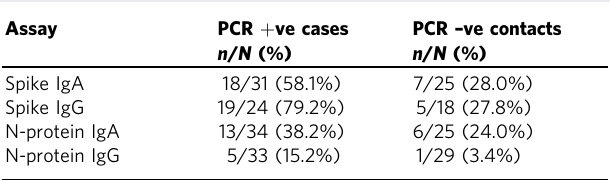
Table 4 Rates of salivo-conversion during the household